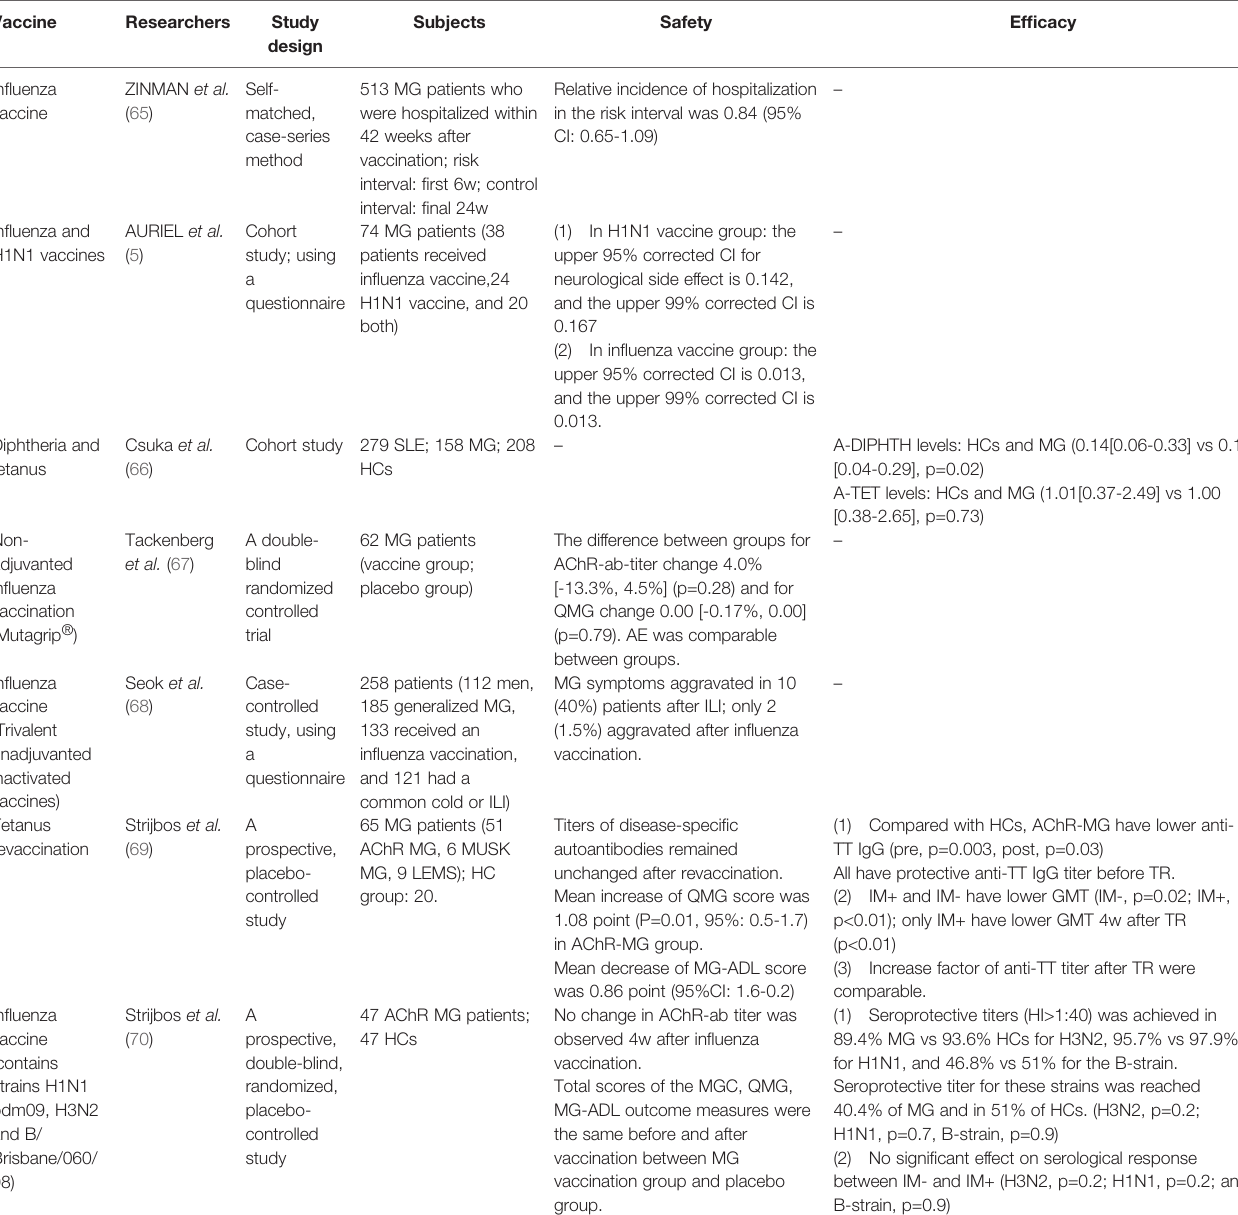
TABLE 1 | Summary of epidemiologic studies on immune response in MG vaccinated patients.